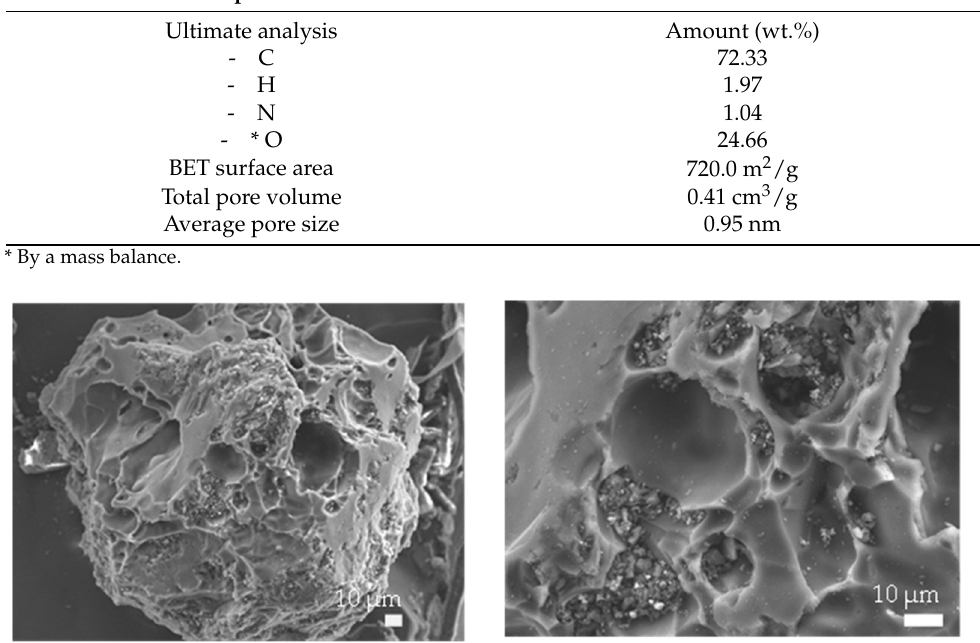
Figure 2. The FT–IR profile of the WCO used in this study.